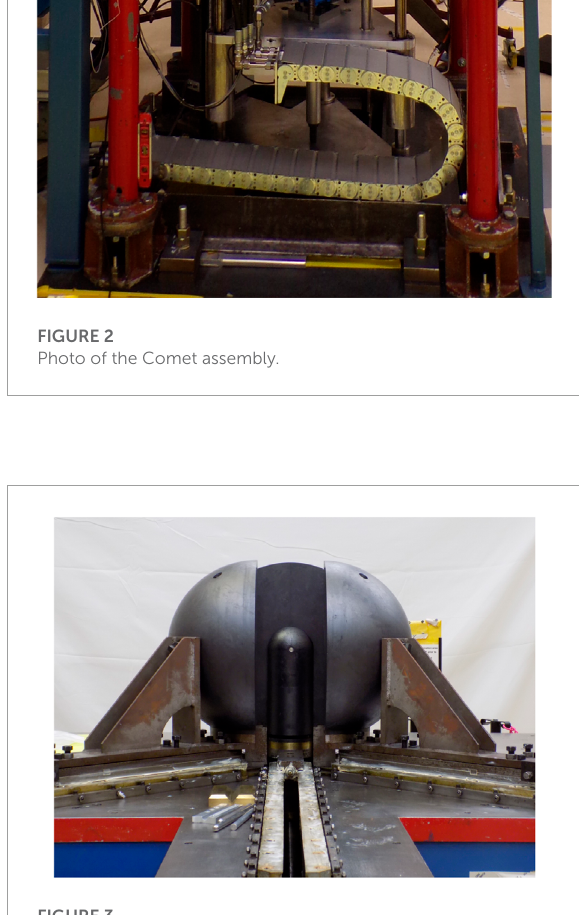
FIGURE 3 Photo of the Flattop